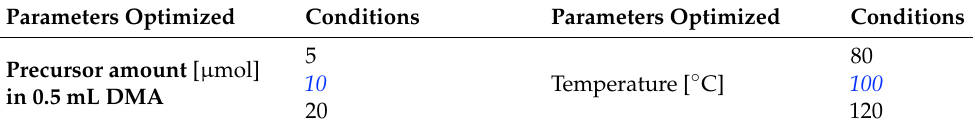
Table 1. Cont. Parameters